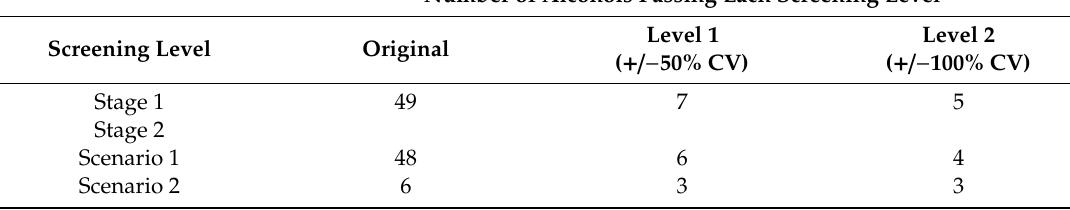
Table 5. Outcomes of property prediction sensitivity analysis. The original analysis was performed using reported or predicted property values only (no error